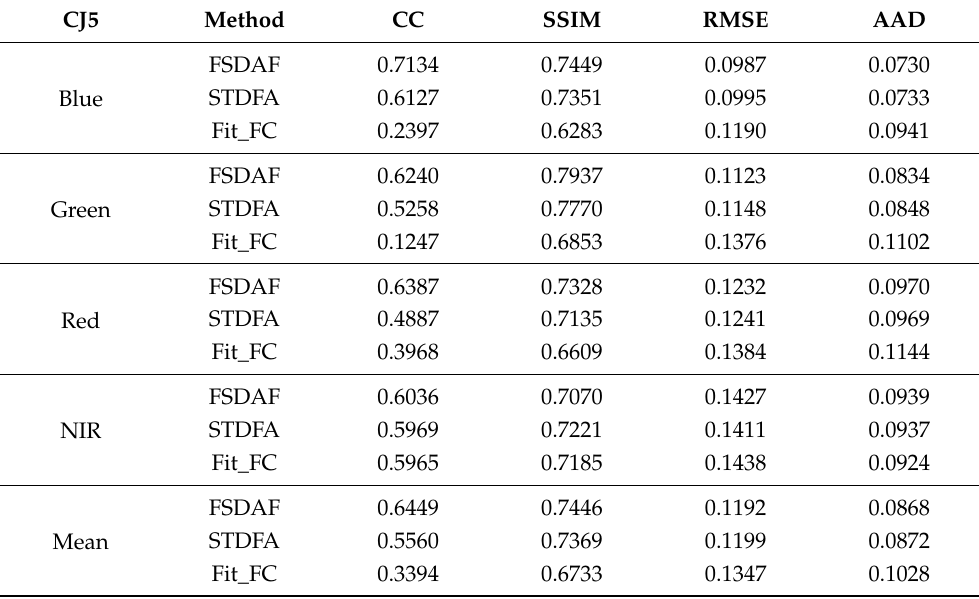
Table 2. The fusion accuracy evaluation of different bands for different models.